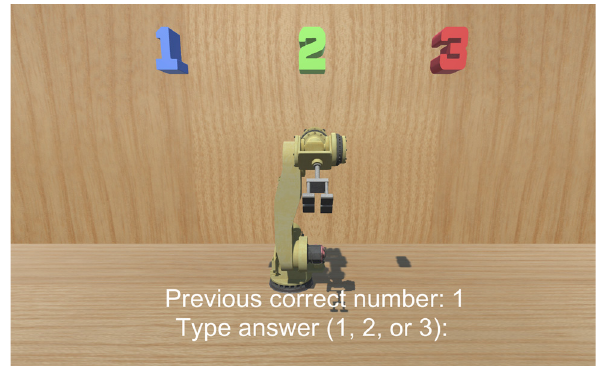
Figure 3: Example image from the robot